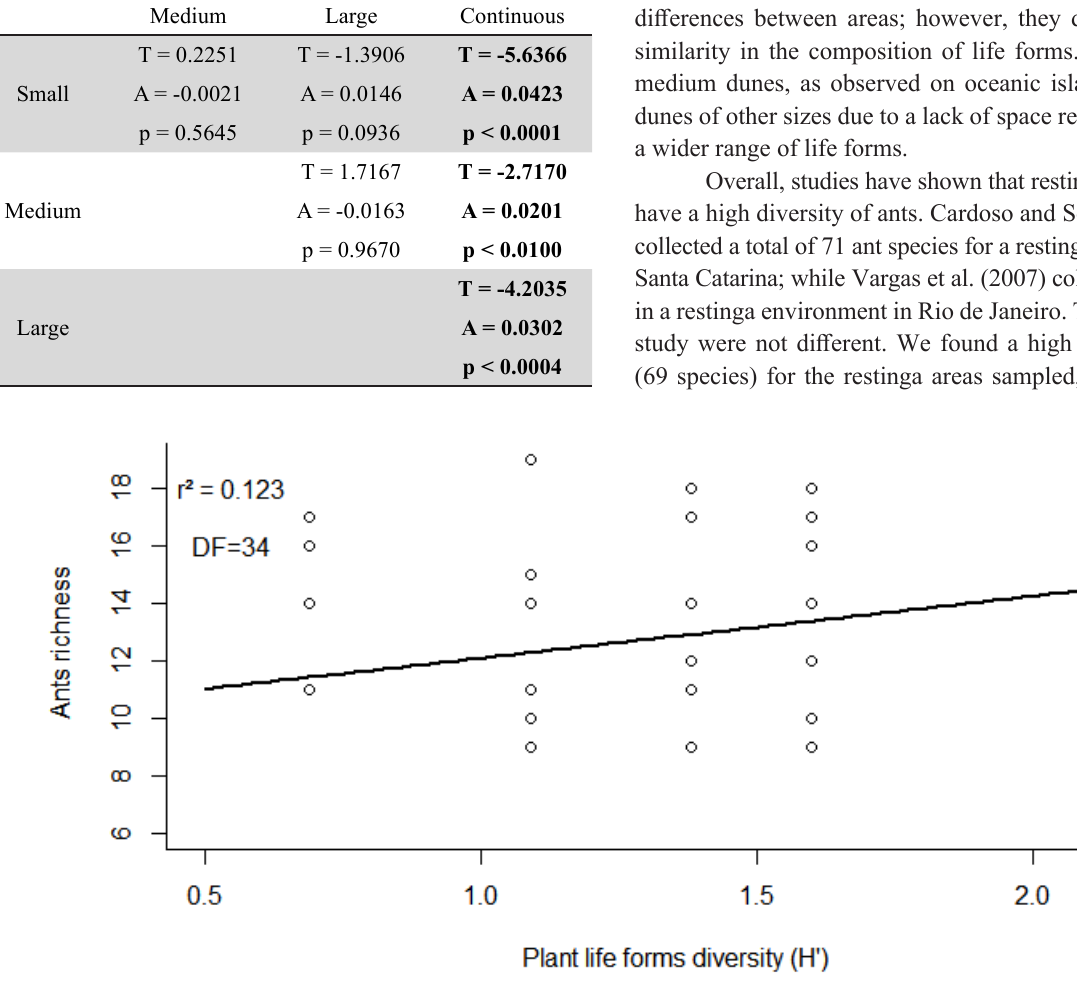
Fig 3 . Positive relationship between ant richness and diversity of plant life forms (H ‘). Curve equation (9.9414+2.1449* x). Analyses based on sample points. Thirty-six sample points are not seen in the graph due to data